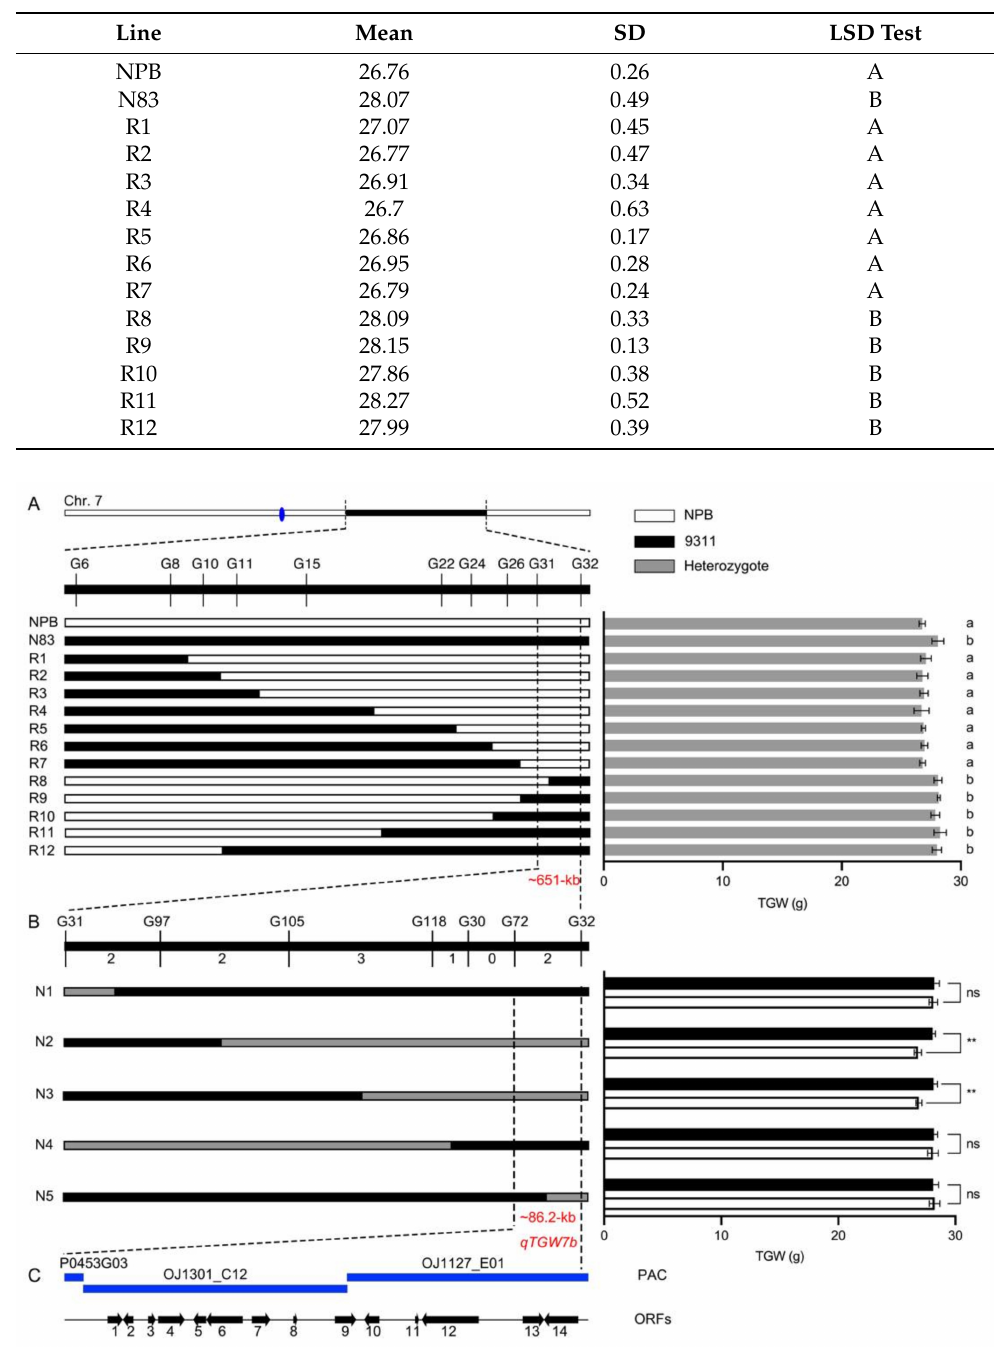
Figure 6. QTLs for grain weight that were found to be segregated in the rice populations. ( A ) Primary mapping of qTGW7b . The blue oval on the chromosome indicates a centromere. Statistical differences are labeled with “a” and “b” using LSD test ( p <0.05, one-way ANOVA). ( B ) Fine mapping of qTGW7b . Student’s t -test was used to generate the p values. Data are means ± SD, ns, p > 0.05, ** p < 0.01. ( C ) Candidate genes in the qTGW7b region. Blue rectangles represent PAC